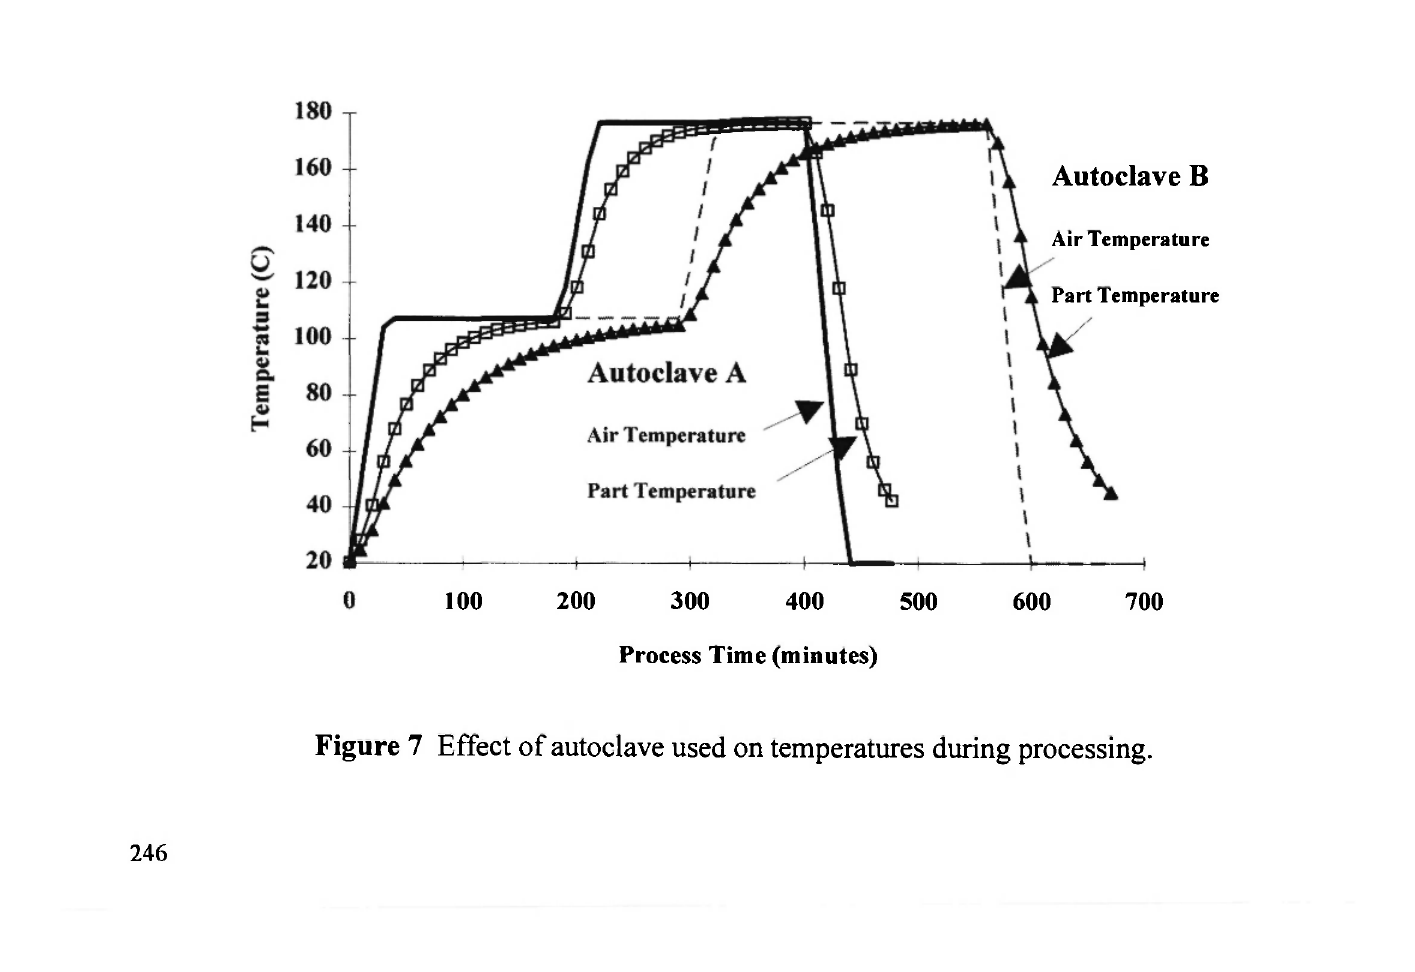
Figure 7 Effect of autoclave used on temperatures during